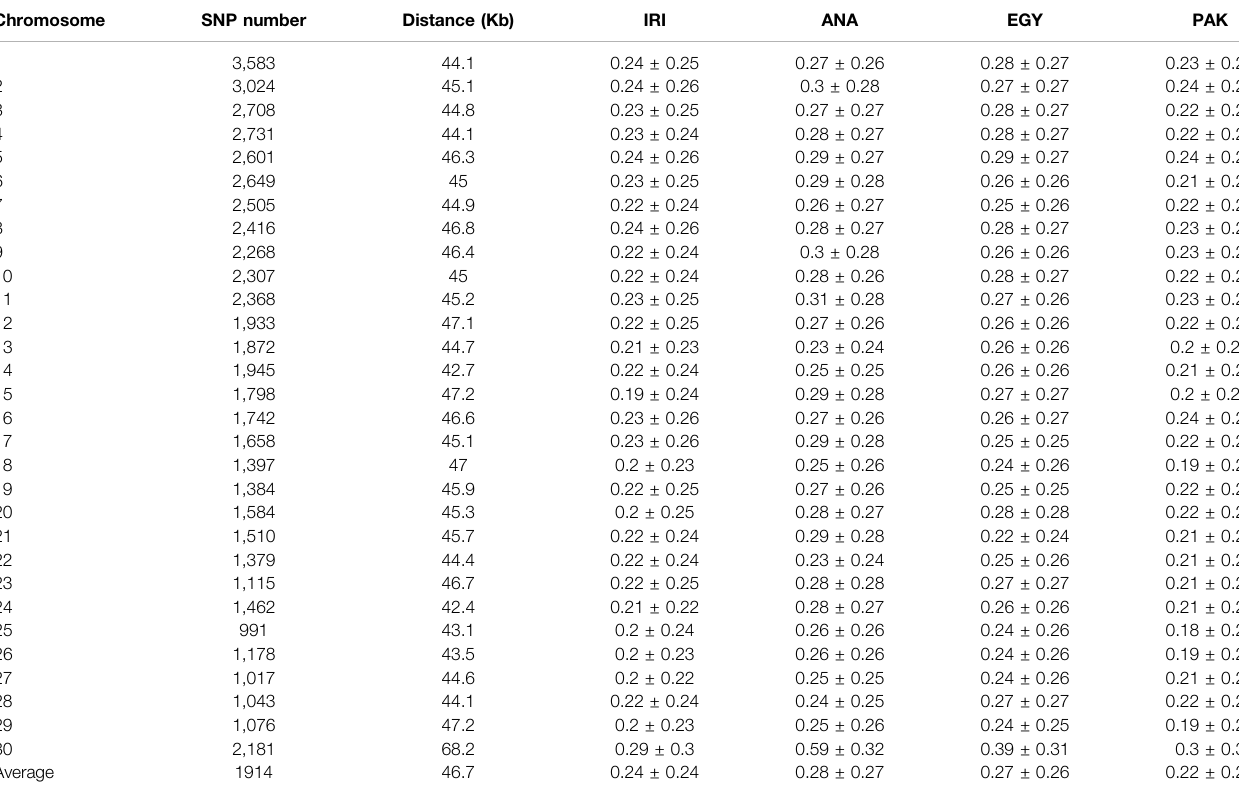
TABLE 2 | Distance and linkage disequilibrium (corrected r 2 ) between adjacent polymorphic SNPs for IRI, ANA, EGY, and PAK water buffalo populations.